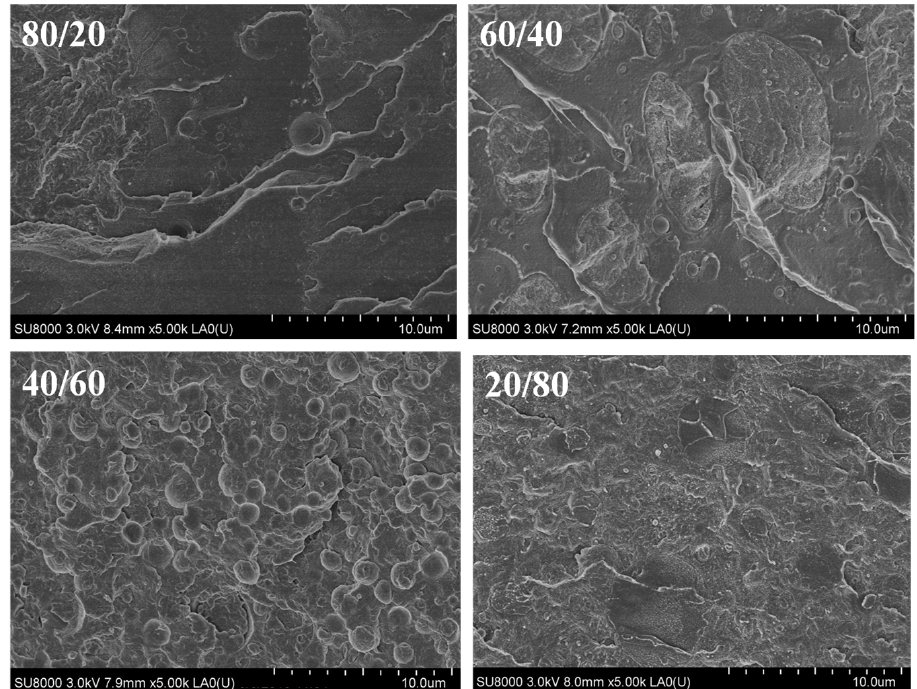
Figure 2. High-resolution SEM micrographs of the PLLA/nylon 11/INT-WS 2 nanocomposites; the inserts are regions with higher magnification (×20 k), highlighting the WS 2 inorganic nanotubes and the PLLA–nylon 11 interface.